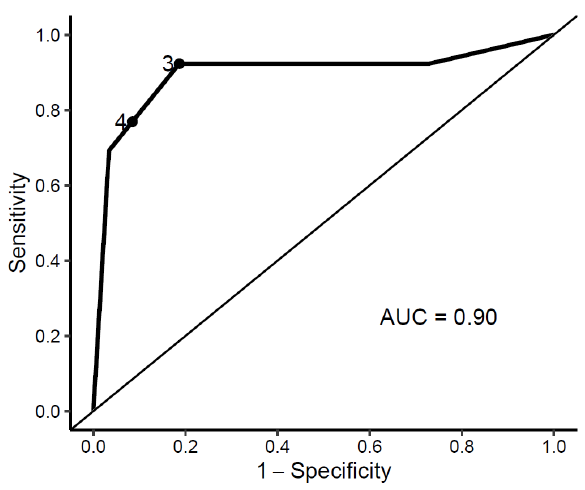
Fig. 1. Analysis of the diagnostic accuracy of VI-RADS system with the ROC curve with highlighted cut-off points at VI-RADS 3 and 4. AUC, Area under the ROC curve.